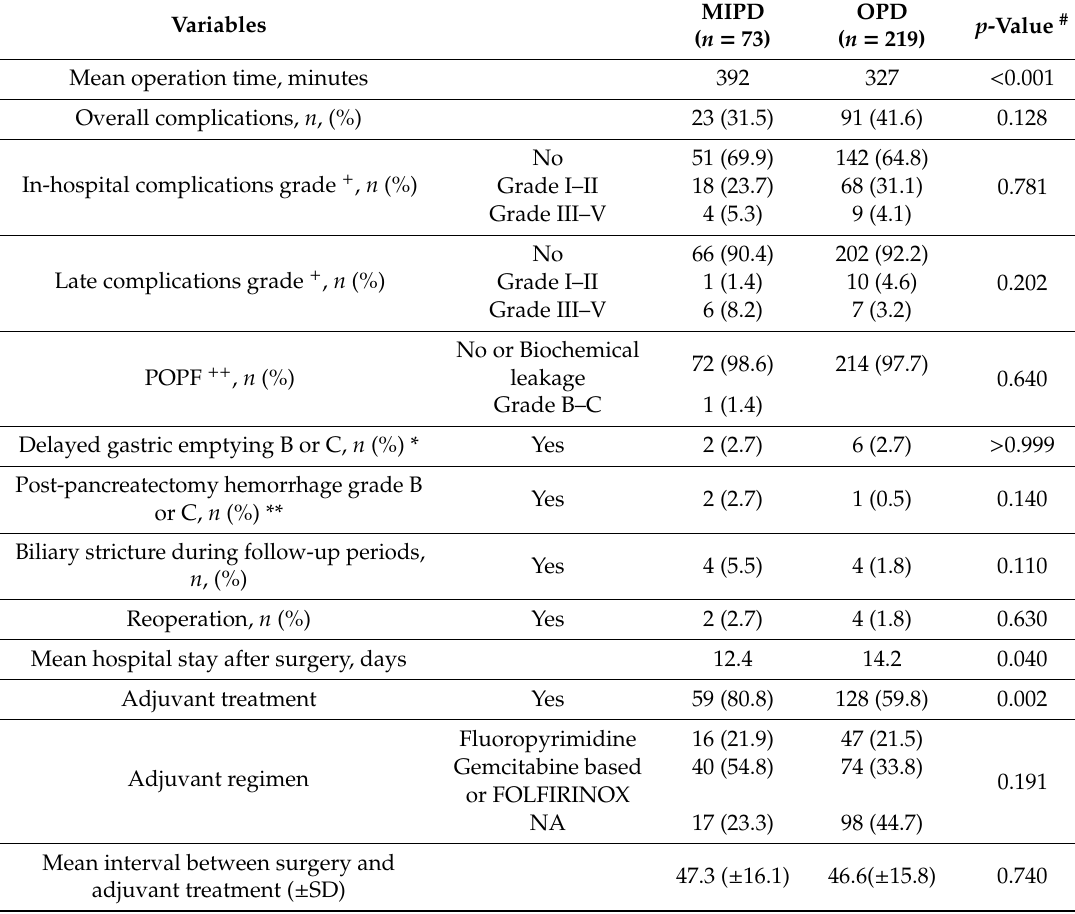
Table 5. Perioperative outcome of MIPD and OPD after propensity score